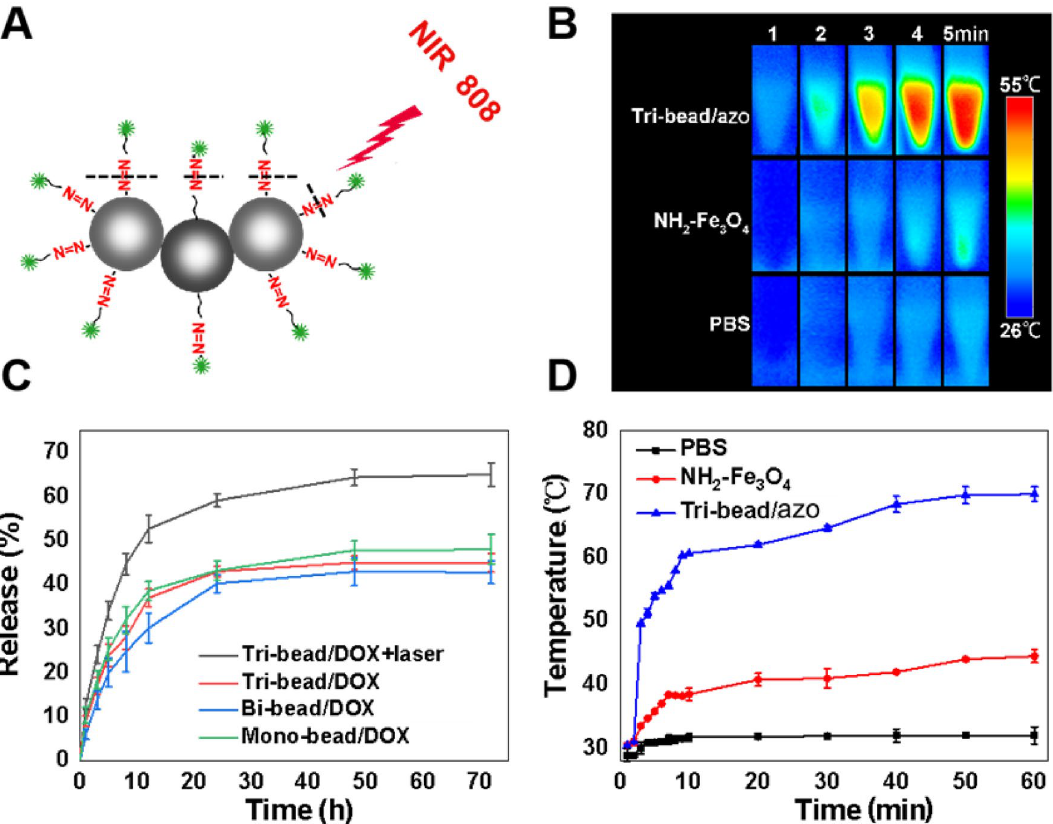
Figure 3. NIR-responsive drug release. ( A ) Schematic illustration of a tri-bead/azo/DOX microrobot irradiated by NIR light. ( B ) Thermographic images and ( C ) DOX release from tri-bead/DOX microrobots and NH 2 - Fe 3 O 4 beads in PBS buffer at pH 7.4 with and without irradiation. Laser irradiation was performed for 5 min at different times. Asterisks indicate significant differences, *p < 0.05, and the sample number was n = 3. ( D ) Photothermal heating curves of tri-bead/azo microrobots, NH 2 -Fe 3 O 4 beads, and PBS solution under 808 nm laser irradiation at a power density of 2 W/cm 2 at different exposure